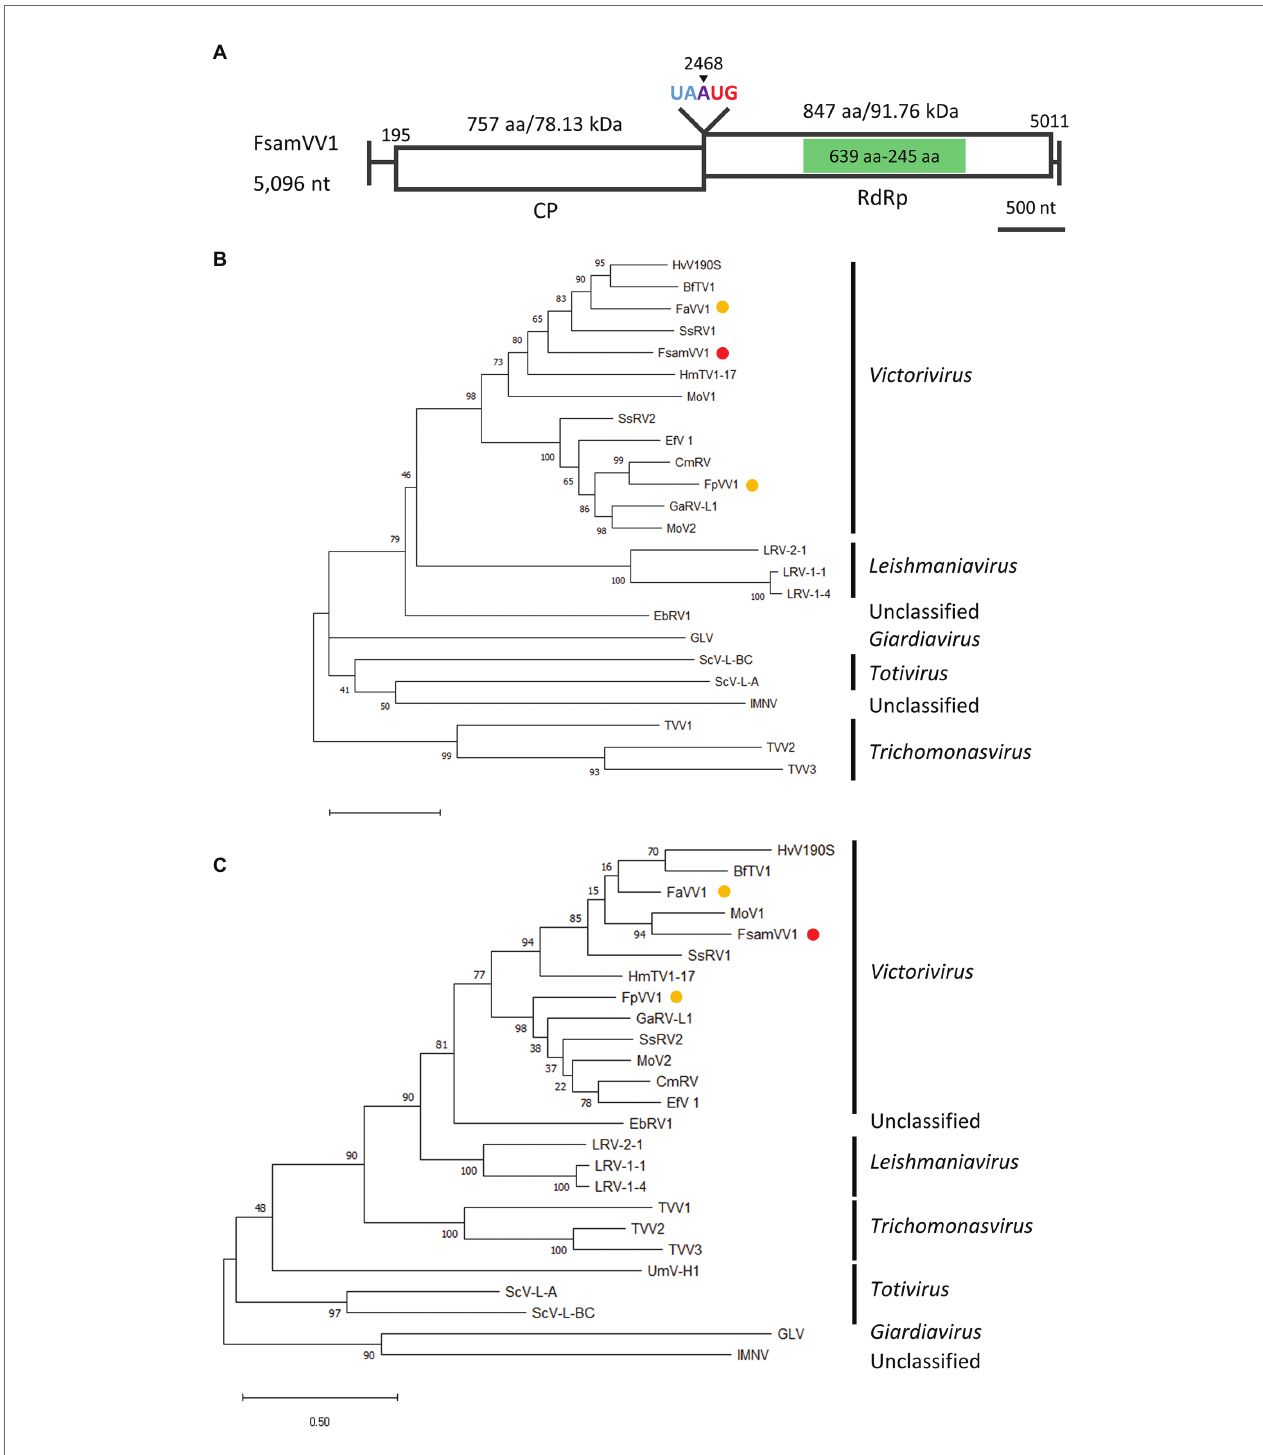
FIGURE 6 | Genome organization and phylogenetic placement of FsamVV1. (A) Schematic representation of the complete genome of FsamVV1. White boxes indicate putative ORFs, and green boxes indicate the conserved RdRp domain predicted by InterProScan. (B,C) ML phylogenetic tree of CP (B) and RdRp (C) of FsamVV1 and other approved and predicted members of the Totiviridae family. A red dot indicates FsamVV1, and yellow dots indicate victoriviruses isolated from Fusarium species. Bootstrap values obtained with 100 replicates are indicated on branches. Branch length corresponds to the genetic distance; the scale bar at the lower left corresponds to a genetic distance of 0.50 in (B) and 0.20 in (C) . A list of full virus names and accession numbers used in this analysis can be found in Supplementary Table S2